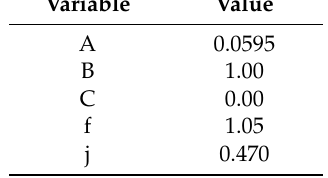
Table 4. Results of the parameters adjusted by the least squares method.